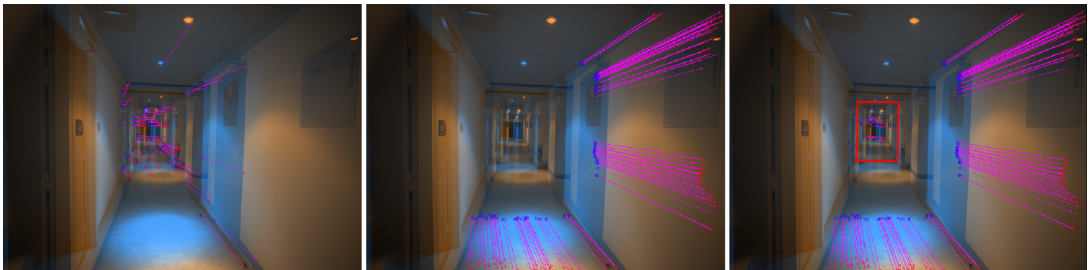
Figure 30. Completion of tie-point extractions by SIFT in low resolution scene part and SIROP in optimal resolution part. ( Left ): tie-points by SIFT. Middle: tie-points by SIROP . ( Right ): SIROP and SIFT points are taken to complete the “far” low resolution scene part (red